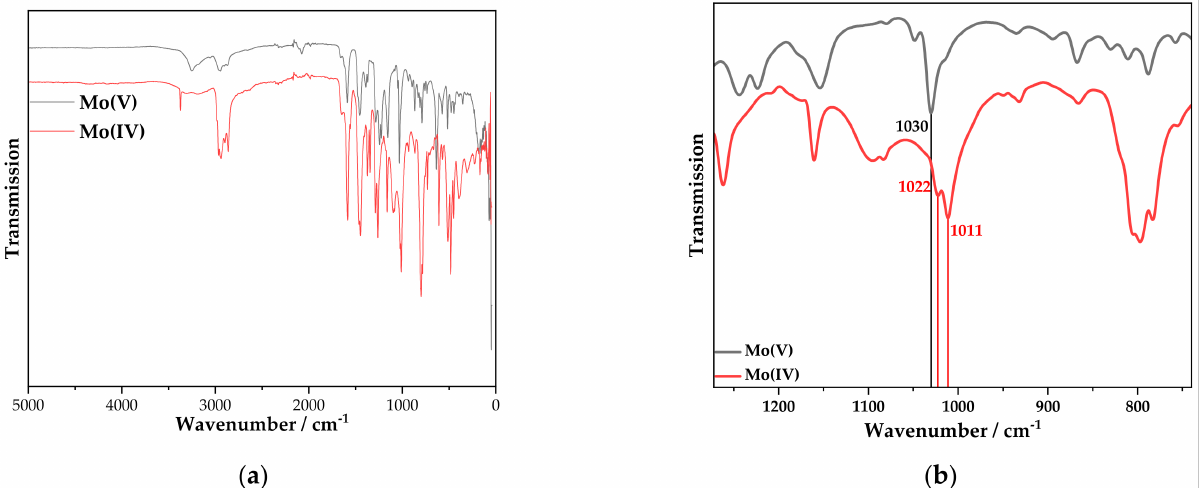
Figure 2. ( a ) IR spectra of the products 4 (black) and 5 (red). ( b ) Section of the IR spectra of the products 4 (black) and 5 (red) to highlight the Mo-N stretching vibration.